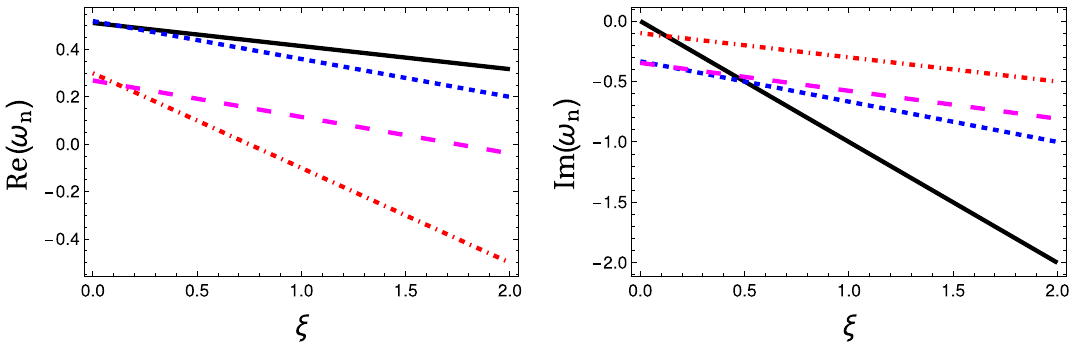
Fig. 5 Quasinormal frequencies ω n vs non-minimal coupling. Left panel: Re (ω n ) versus ξ for four different cases: (1) m = 2 = n (solid black line), (2) m = 2 , n = 1 (blue short dashed line), (3) m = 1 , n = 0 (dotted-dashed red line)and (4) m = 1 = n (magenta long dashed line).